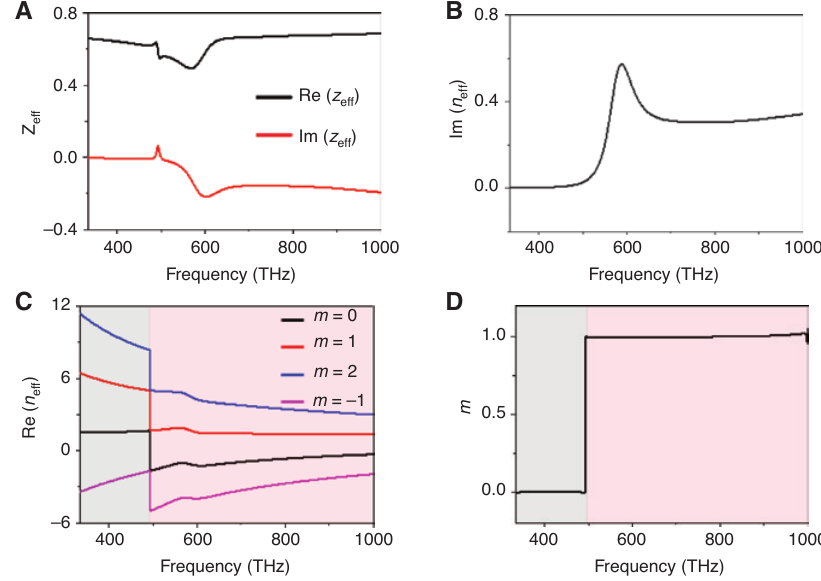
Figure 4: Effective parameters for the homogenized seven layers of gold nanoparticles. (A) The effective impedance z and (B) the imaginary part of the refractive index n eff (C) Examples of multiple branches of the real parts of the refractive index n causality condition. (D) The branch m determined by our homogenization method [Eq.